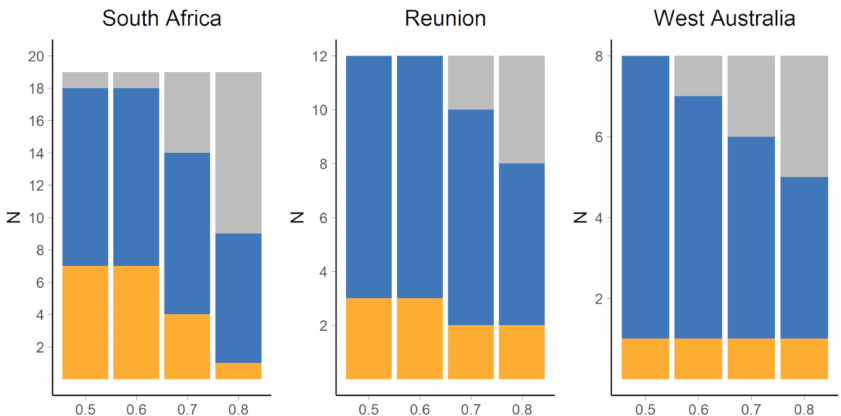
Figure 3. Estimated number of Pakistan-like (yellow), West nursery (blue) and undetermined (grey) origin yellowfin tuna ( Thunnus albacares ) samples captured in three different fishing grounds of the Indian Ocean. Results are based on multinomial logistic regression (MLR) framework. Four probability thresholds (0.5–0.8) are